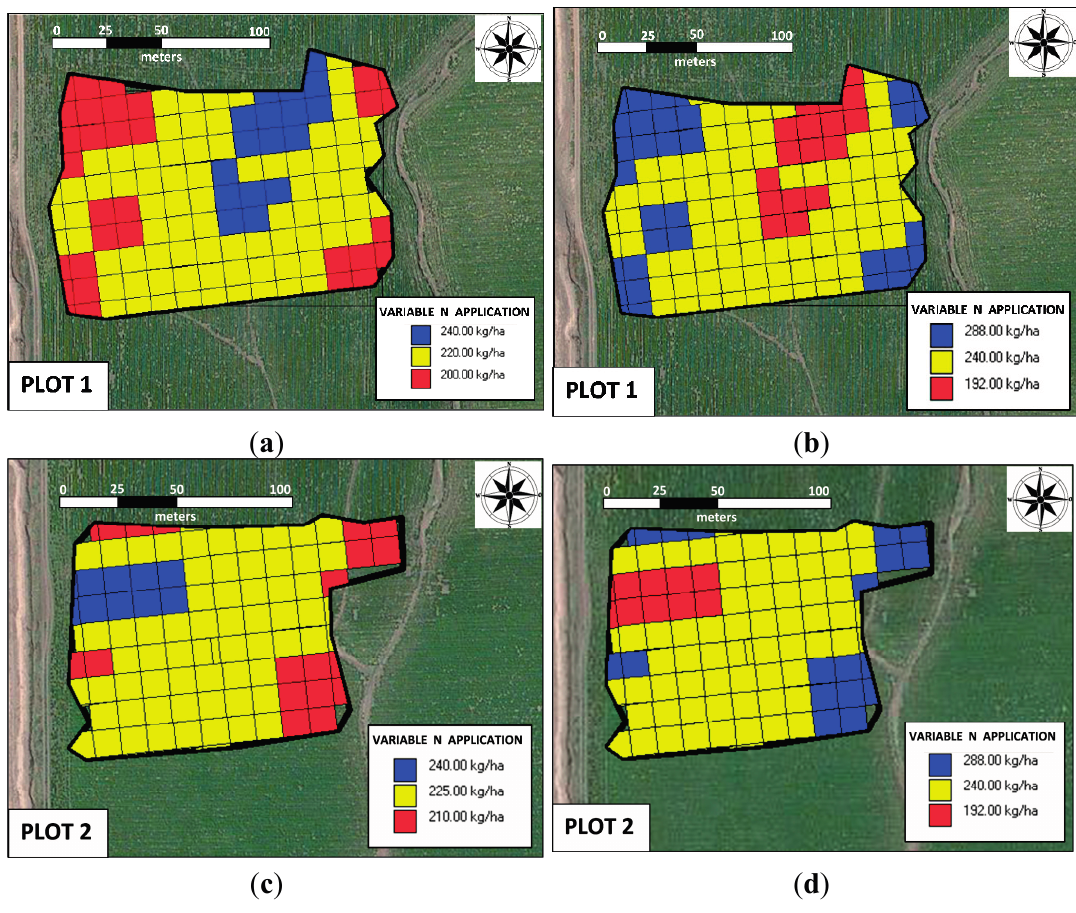
Figure 7. Site-specific precise nitrogen management units for two fields: ( b ) and ( d ) conservative application, and ( a ) and ( c ) risky